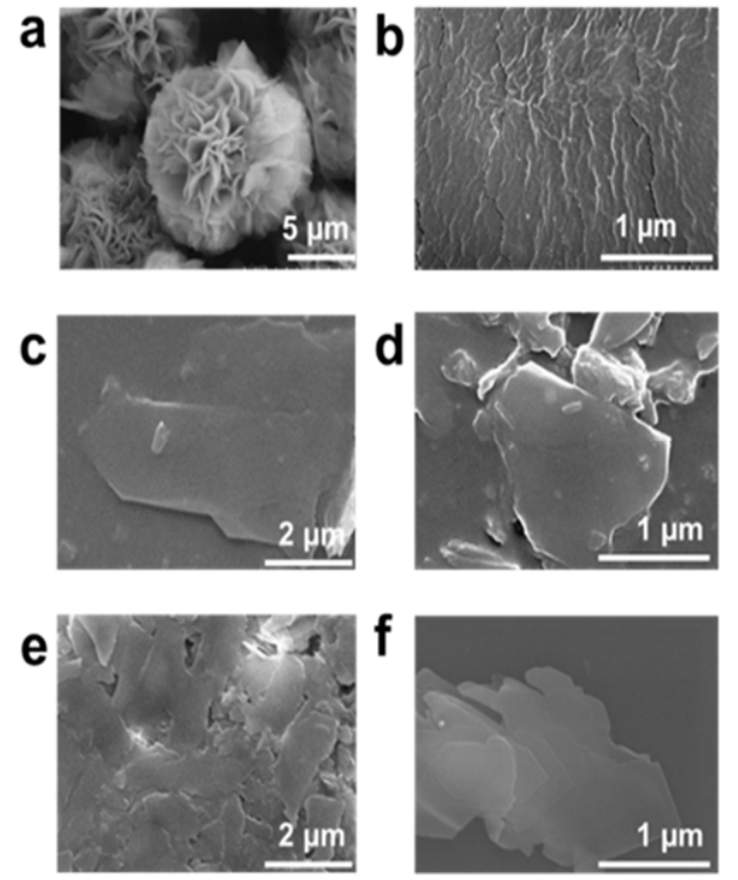
Figure 4. Effect of planetary milling and purification of exfoliated MFI zeolite nanosheets, ( a ) before the milling of nanosheets, ( b ) after planetary milling for 15 min the presence of PVP surfactant, ( c ) after the centrifugation for one time. The surfactant embedded in the MLSil ‐ 1Ns was still present in the solution. The large part of interlocked nanosheets exfoliated in few layers, ( d ) major part of surfactant has been removed from the exfoliated nanosheets suspension however some part was found remaining even after two times centrifugation, ( e , f ) cleaned and purified exfoliated nanosheets were obtained after samples were centrifuged three times.